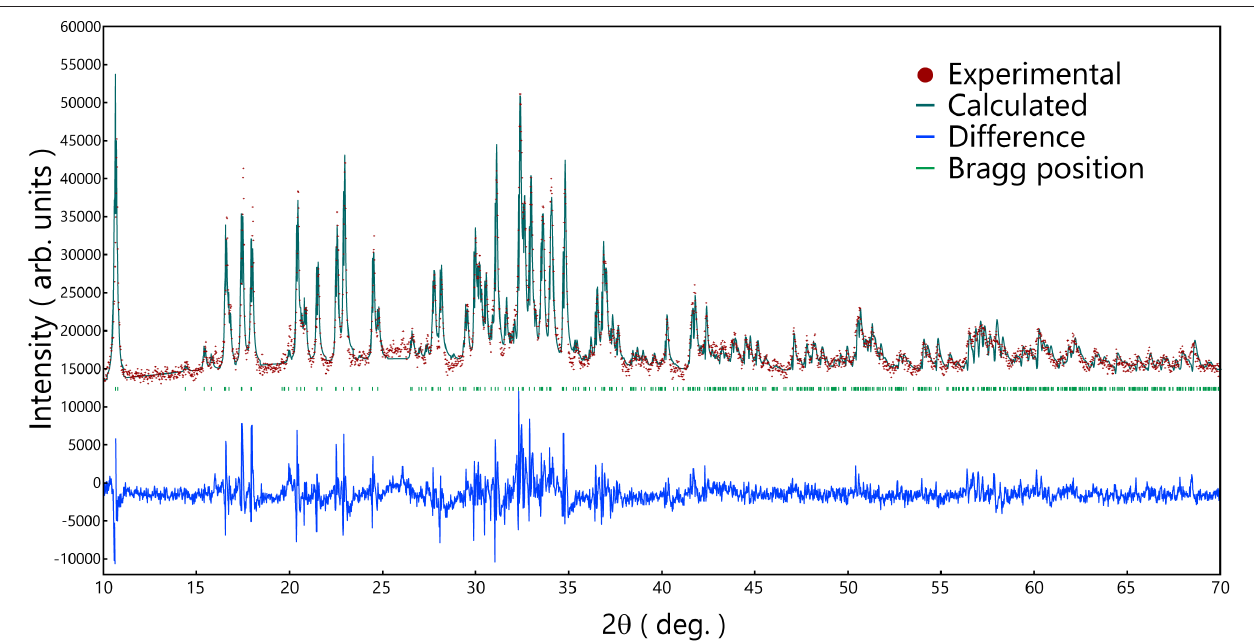
FIGURE 6 | XRD pattern and Rietveld refinement for the mixture of heat-treated Na 2 NiP 2 O 7 and CB.